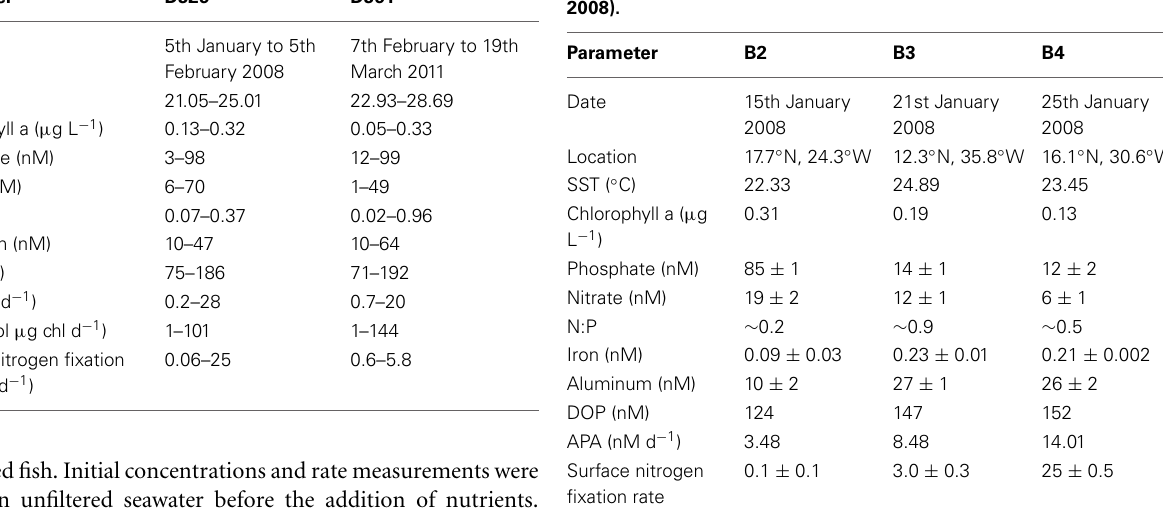
Table 3 | Date, location and initial concentrations ( ± standard deviation) of inorganic and organic nutrients (nM), trace metals